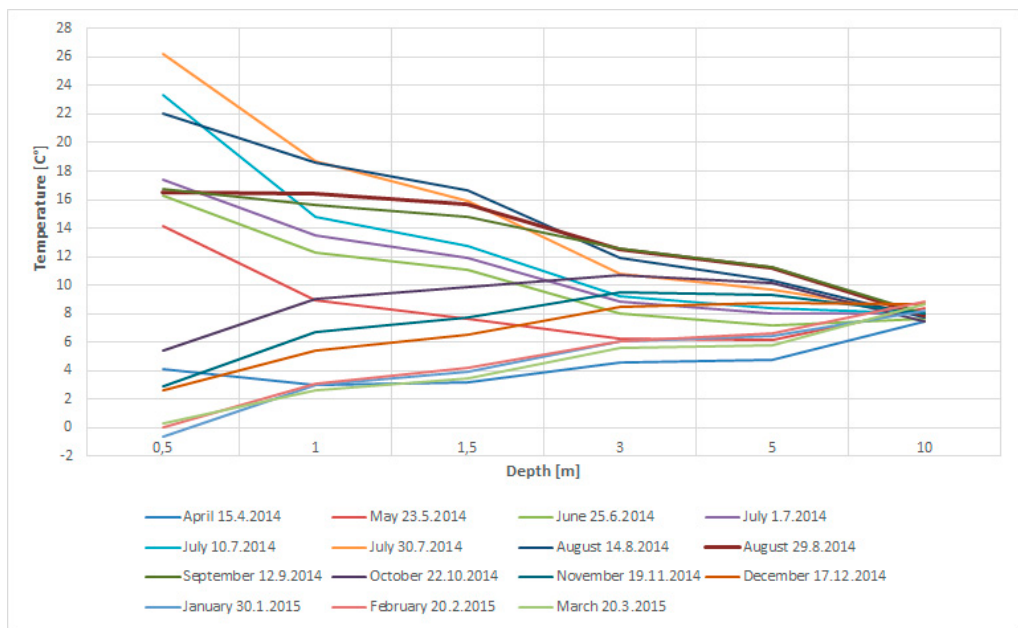
Figure 7. The temperatures in different layers from 0.5 m to 10 m are monitored at one hole. The temperatures vary between 7.4 °C and 8.8 °C at a depth of 10 m.